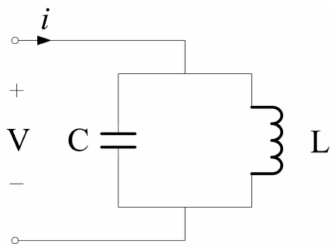
Figure 1. The inductance–capacitance (LC) oscillating